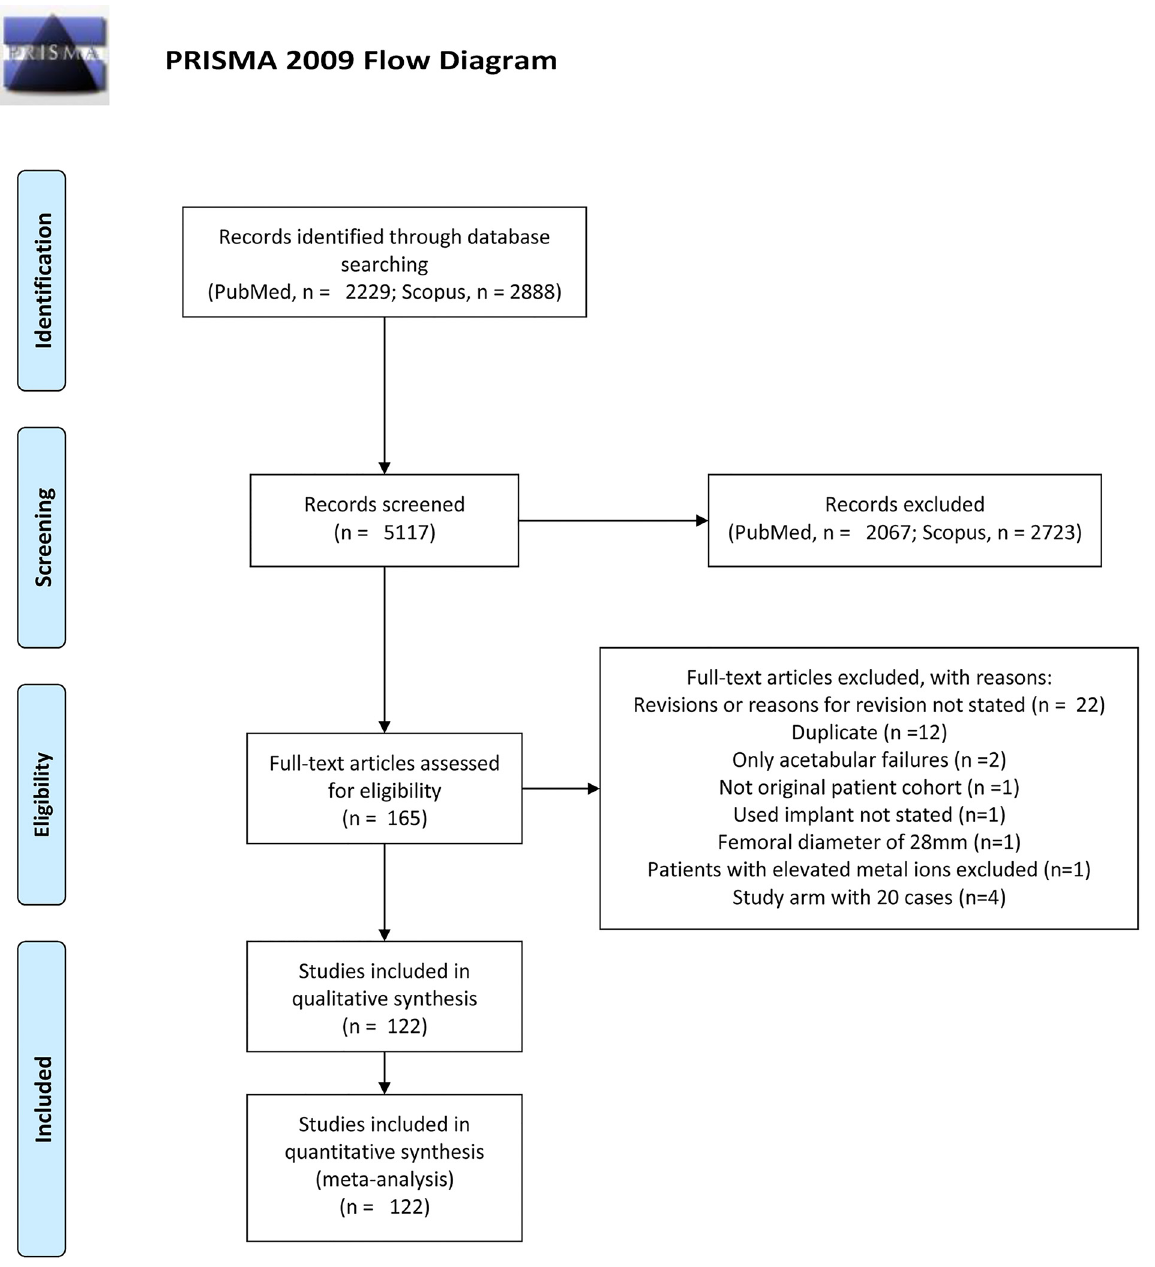
Fig 1. Flow chart of the study